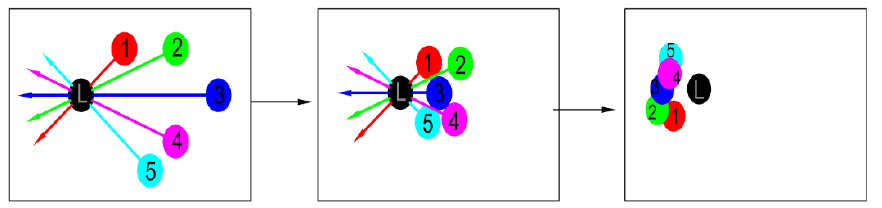
Figure 5. The principle of an all-to-one strategy [25].